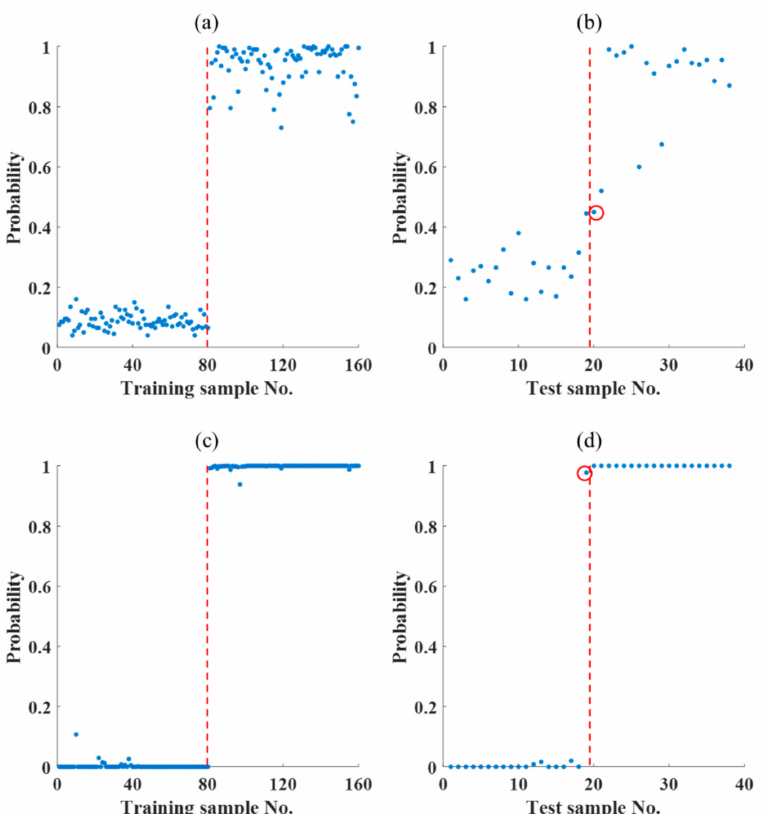
Figure 12. Probability of being signal in training and test samples by the trained RF and CNN. ( a , b ) are 160 training samples and 38 test samples from RF; ( c , d ) are 160 training samples and 38 test samples from CNN.